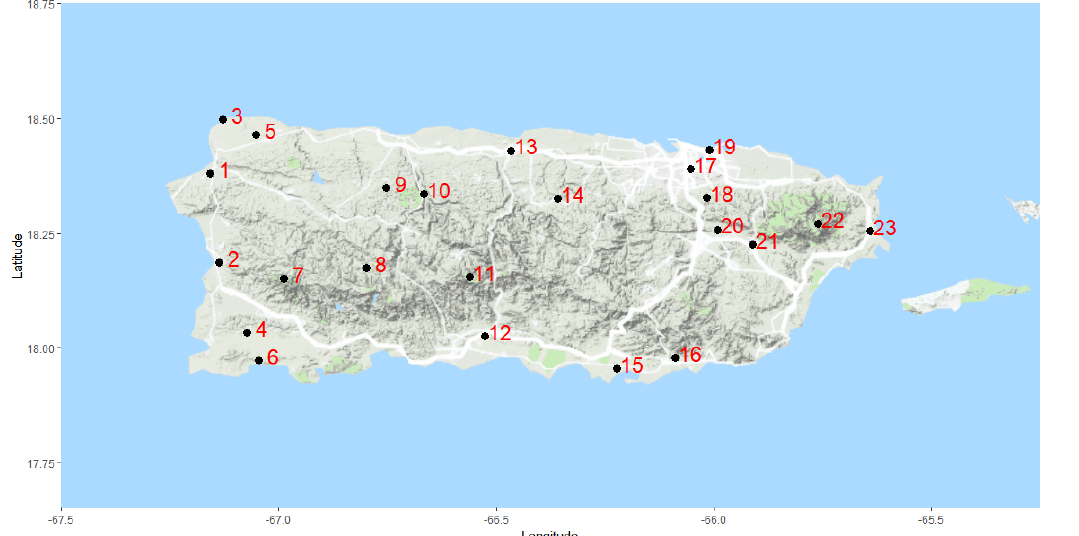
Figure 1. The 23 weather stations of interest in Puerto Rico. This image was created using a combination of © Google Maps 2018, Kahle and Wickham (2013), and Wickham (2016).